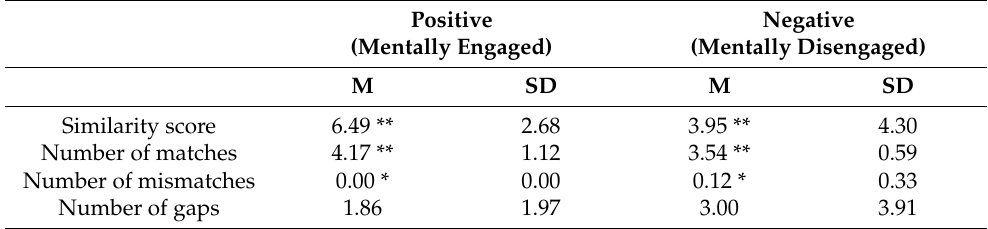
Table 1. Statistics on the scanpath alignment measures according to the engagement level.